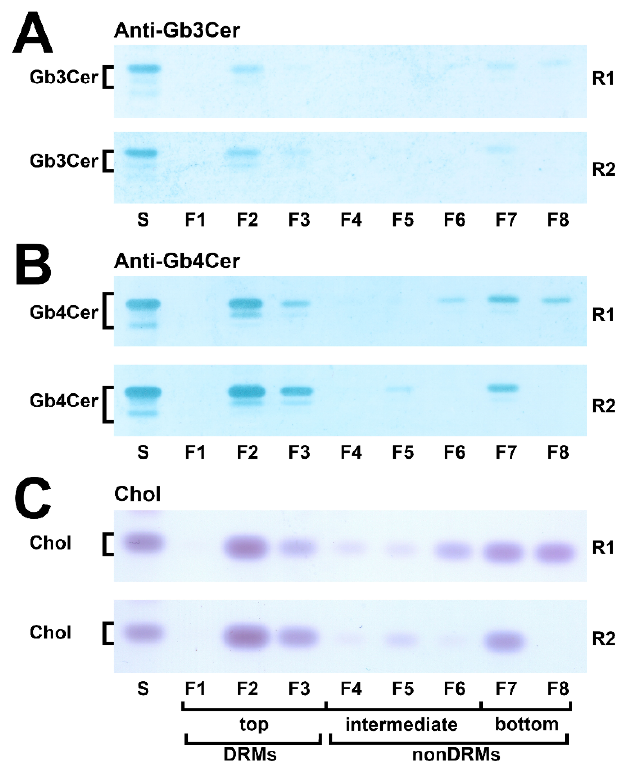
Figure 5. Distribution of Gb3Cer ( A ), Gb4Cer ( B ) and cholesterol ( C ) among sucrose gradient fractions F1 to F8 obtained from pHCoEpiCs. Anti-Gb3Cer ( A ) and anti-Gb4Cer ( B ) antibodies were used for immunochemical detection and manganese(II)chloride for cholesterol (Chol) detection in samples of two independent biological replicates (R1 and R2) obtained from pHCoEpiCs cultivated in medium with low serum. Each gradient preparation corresponds to 5 × 10 6 cells. Standard (S) equivalents of 2 µg and 0.2 µg of reference neutral GSLs from human erythrocytes and 1 µg of reference cholesterol (Chol) were employed as positive controls for the anti-Gb3Cer and anti-Gb4Cer TLC overlay assay and the cholesterol detection, respectively. DRMs, detergent resistant membranes.